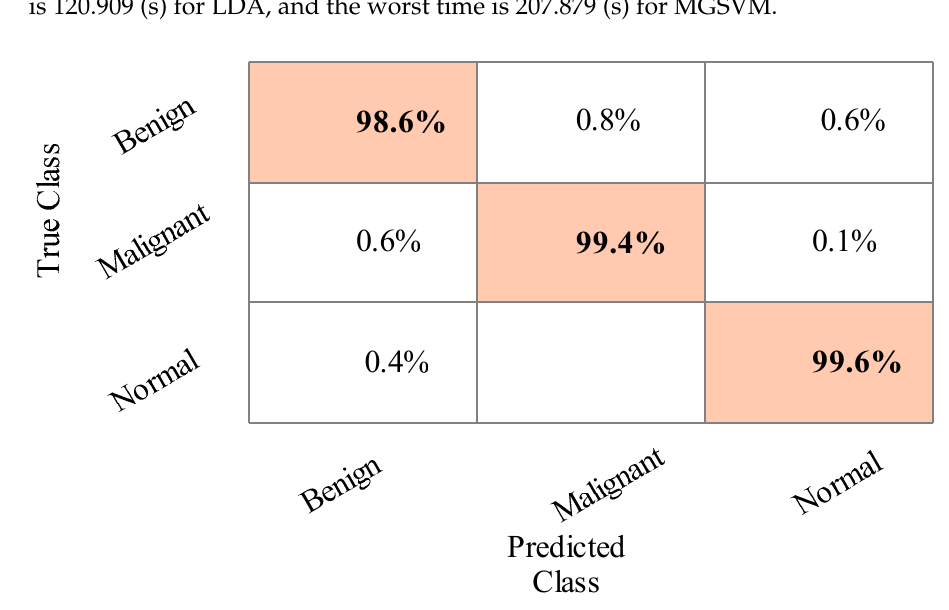
99.3%, 99.3%, 99.3%, 99.3%, 0.7%, and 11.112 (s), respectively. The MGSVM and